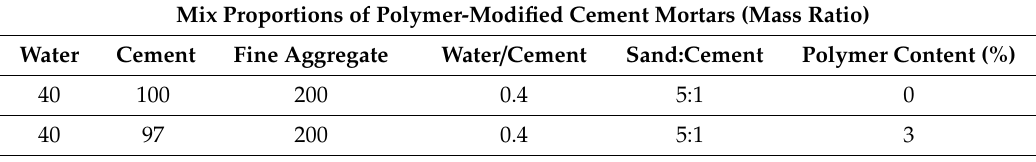
Table 4. Mix proportions for polymer-modified cement mortars and substrate